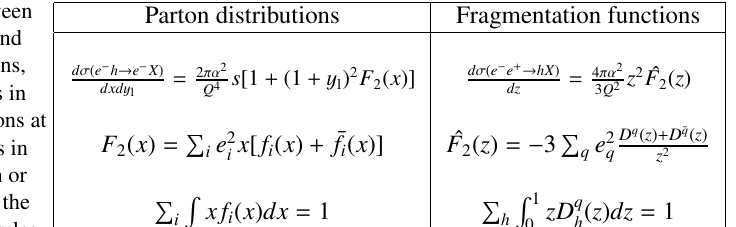
Table 1. The analogy between fragmentation functions and parton distribution functions, showing the cross sections in terms of the structure functions at LO, the structure functions in terms of the fragmentation or distribution functions, and the respective momentum sum rules.